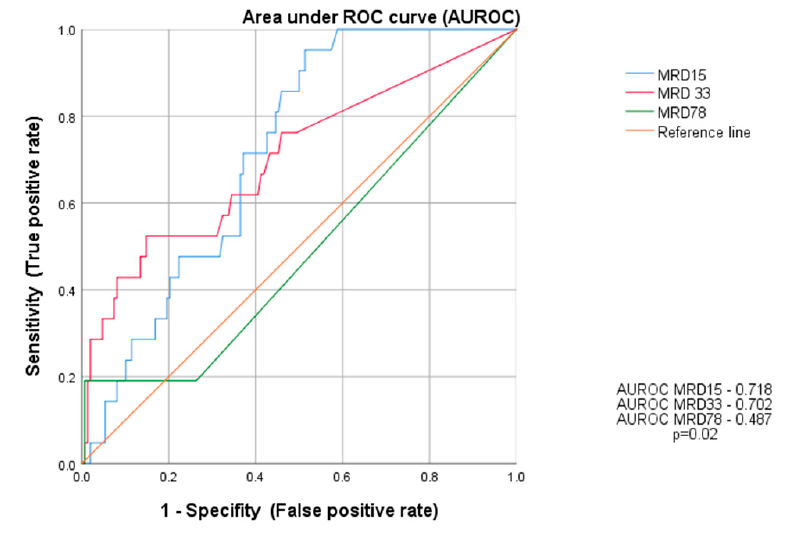
Figure 6. The area under the ROC curve (AUROC) for MRD assessment at days: 15 (TP1), 33 (TP2), and 78 (TP3).